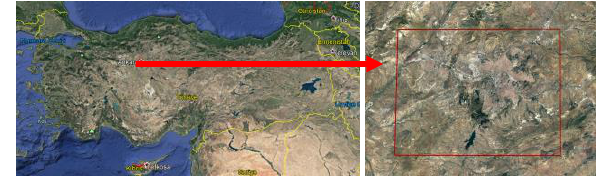
Figure 1. Location of the study area (image credit: Google Earth).